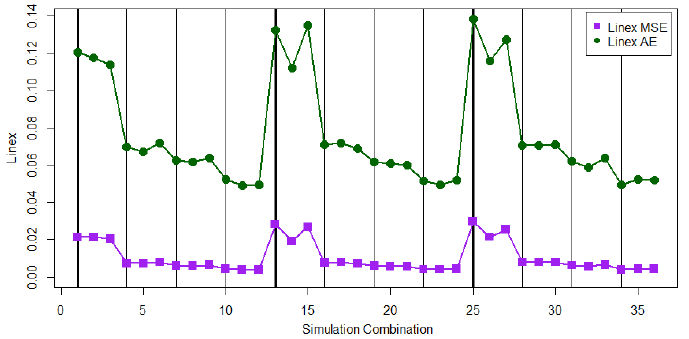
Figure 9. The values of EAE ( ˆ δ Linex ) and EAE ( ˆ δ Linex ) for the case of β 1 = β 2 . Table 4. The ESE and EAE for ˆ δ Linex under different Burr type XII